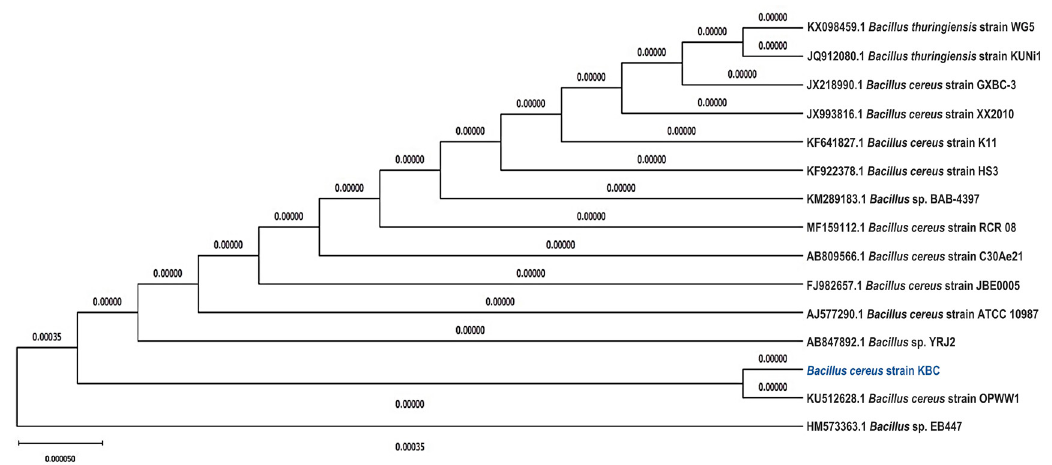
Figure 2. Phylogenetic tree of B. cereus strain KBC with evolutionary distance. The B. cereus KBC was closely related to B. cereus strain OPWW1.